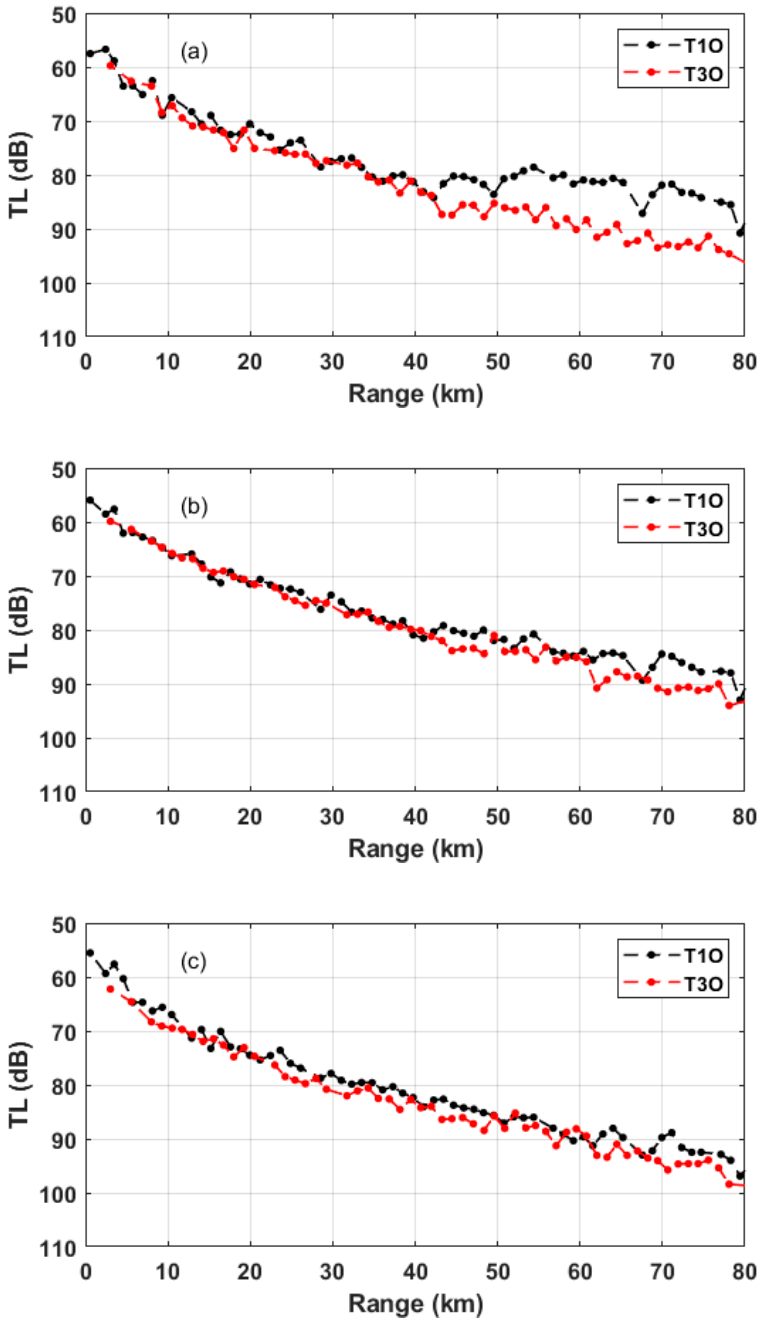
Figure 7. Comparison of experimental TLs of T1O and T3O for the central frequency 1000 Hz, source depth 7 m, and receiver depth 11 m ( a ), 37 m ( b ), and 71 m ( c ).